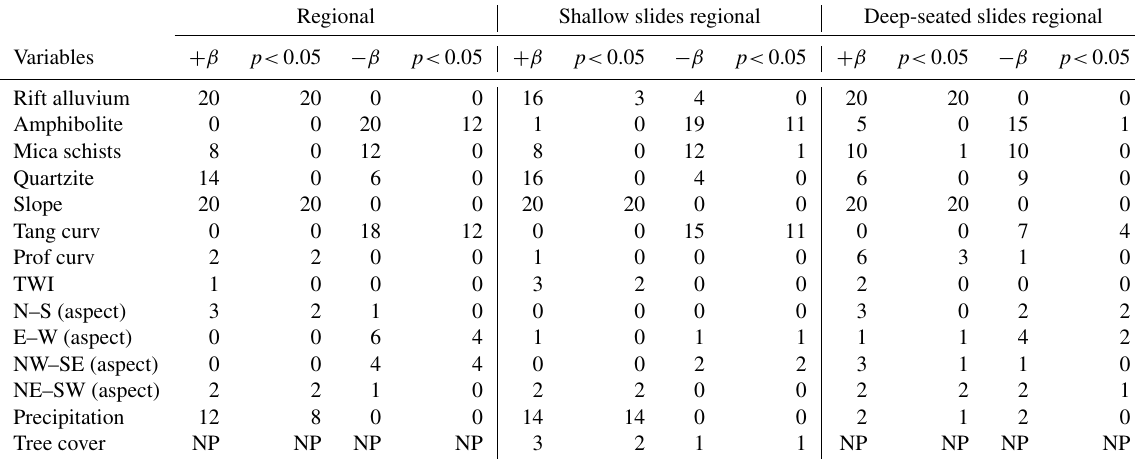
Table 4. Overview of the frequency a variable is selected with a positive coefficient ( + β , shaded cells) or negative coefficient ( − β , unshaded cells) based on the AIC criterion and the frequency that variable is found to be significant on a p< 0.05 level. This is given for the models at the regional level including all landslides, including only the shallow landslides and only the deep-seated landslides. The distinction between the latter two is made based on a 3m threshold of the depth of the sliding plane. Regional Shallow slides